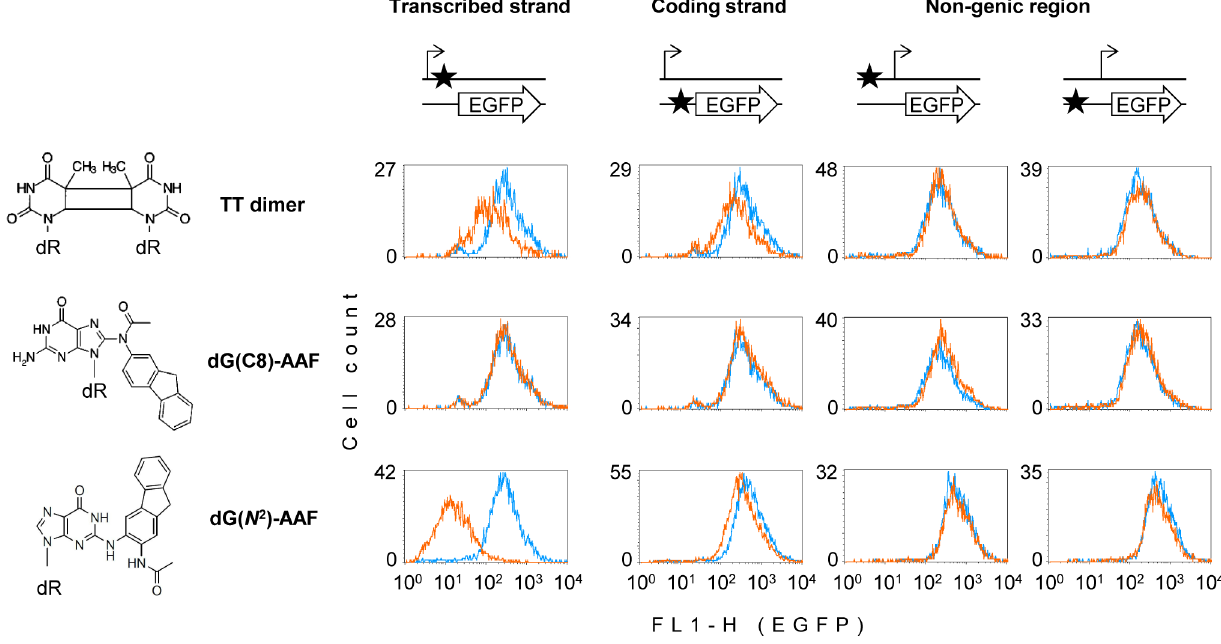
Figure 1. Effects of single adducts on the EGFP gene expression in the GM16095 (CS-B) cell line. The protein coding sequence (arrow) and the transcription start (broken arrow) are represented out of scale, along with the adduct position (star) with respect to the transcription unit. Overlaid fluorescence distribution plots were obtained by flow cytometric analyses of cells transfected with vectors carrying the specified adducts (amber line) and with the control constructs obtained by incorporation of the unmodified deoxyribo-oligonucleotide (blue line).